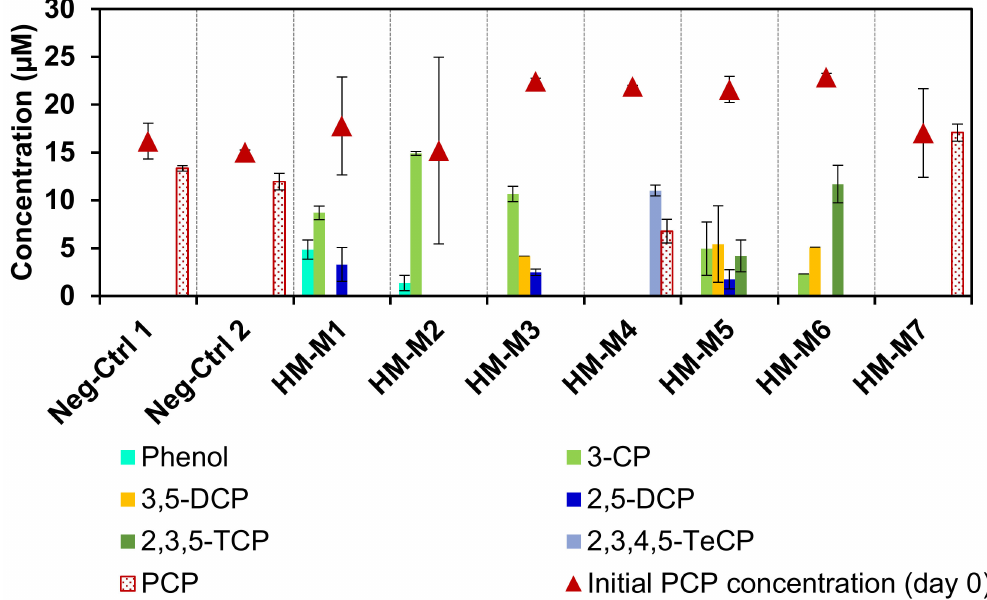
Figure 2. Pentachlorophenol (PCP) and metabolite concentrations on the first day (point graph) and on day 20 (column chart) of the 3rd transfer. One positive control was the culture with HM-M1, two negative controls were the culture without addition of any humin (HM) (Neg-Ctrl 1) and the culture without inoculum (Neg-Ctrl 2). No dechlorination was detected in the negative controls and the culture with HM-M7.